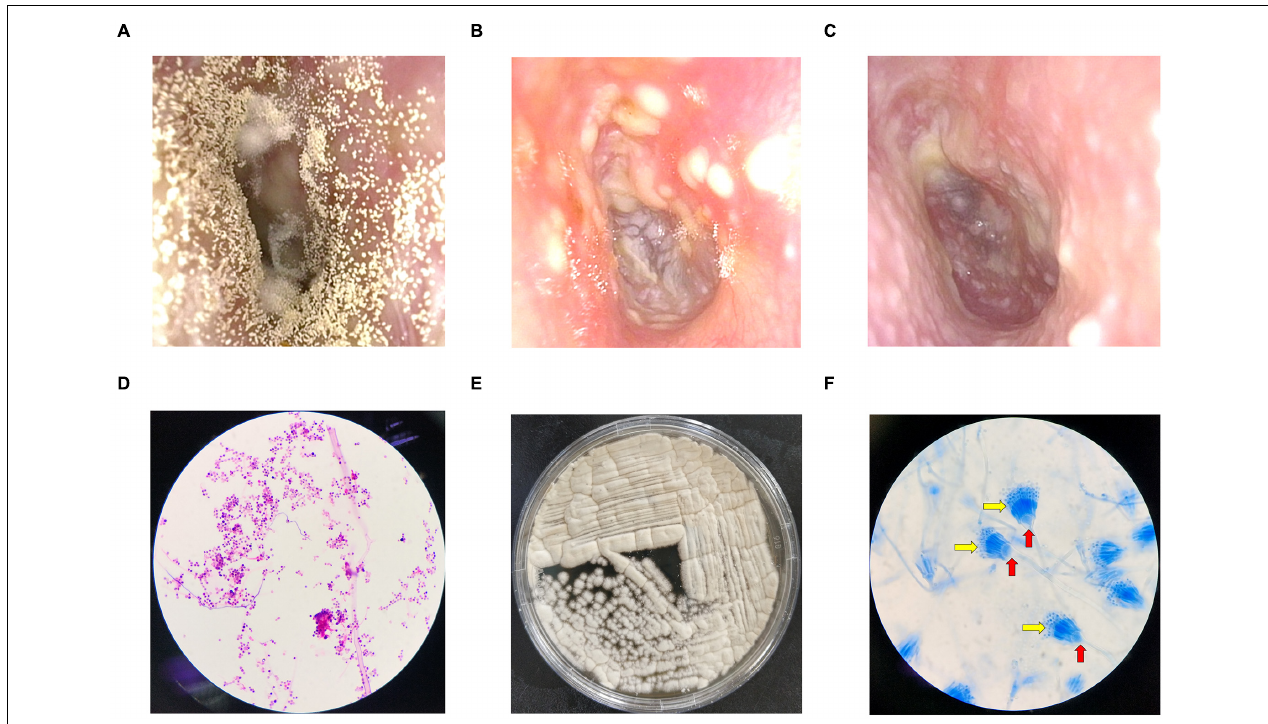
FIGURE 1 | Fiberoptic otoscopy, fungal culture, and microscope examination. (A) An example of the external auditory canal before treatment. (B) Seven days after bifonazole treatment. (C) Fourteen days after bifonazole treatment. (D) Gram-stained smear at 100 × magnification. (E) An example of fungal culture. (F) Lactophenol cotton blue stained smear at 100 × magnification. Red arrows refer to conidiophore vesicles, and yellow arrows refer to fan-shaped head.